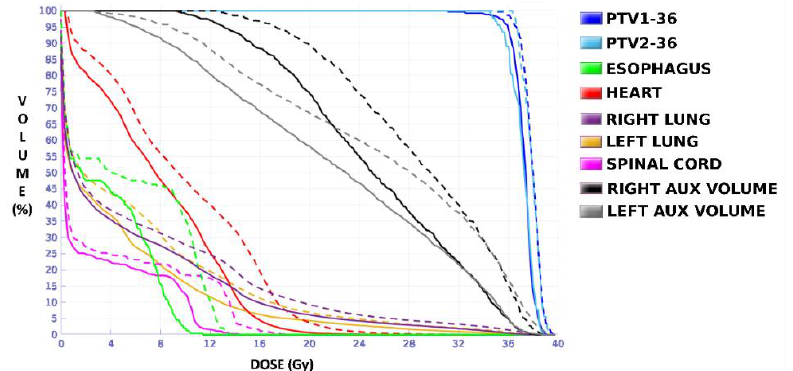
Figure 10. DVHs of the planning solutions for Case 3 under EARL1 (dashed lines) and EARL2